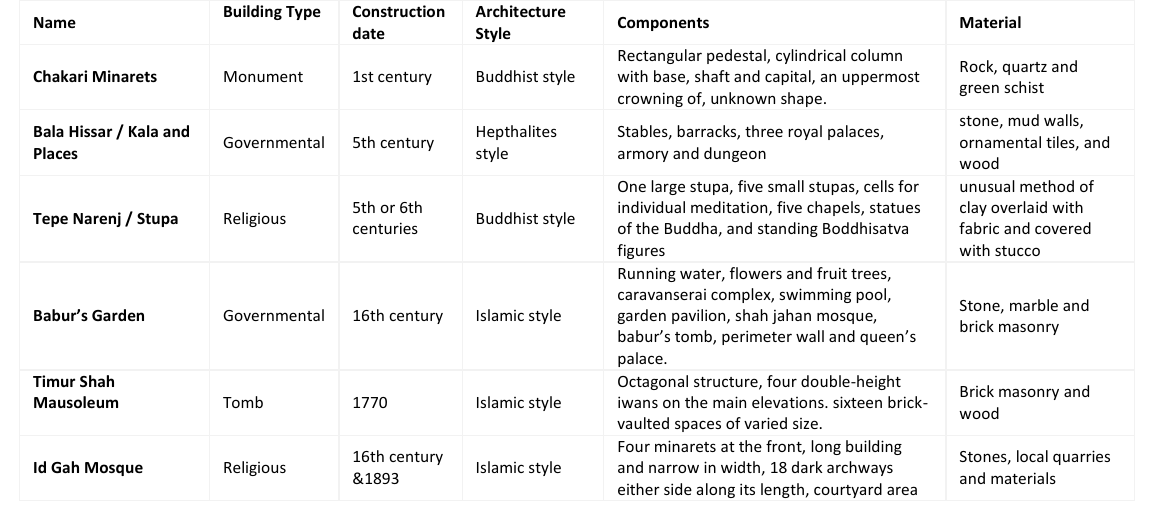
Table 1 Summary of the evaluated architectural monuments in Kabul